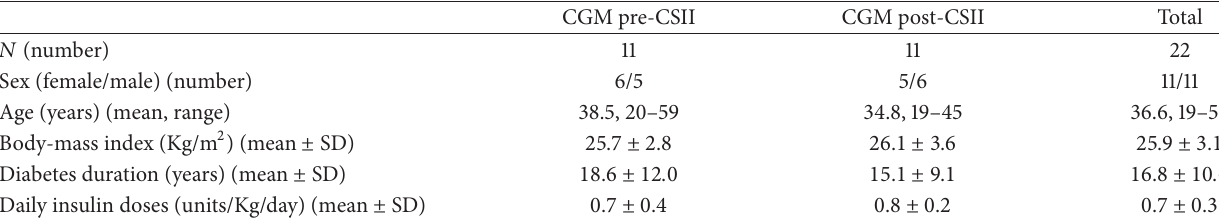
Table 1: Baseline characteristics of the patients.